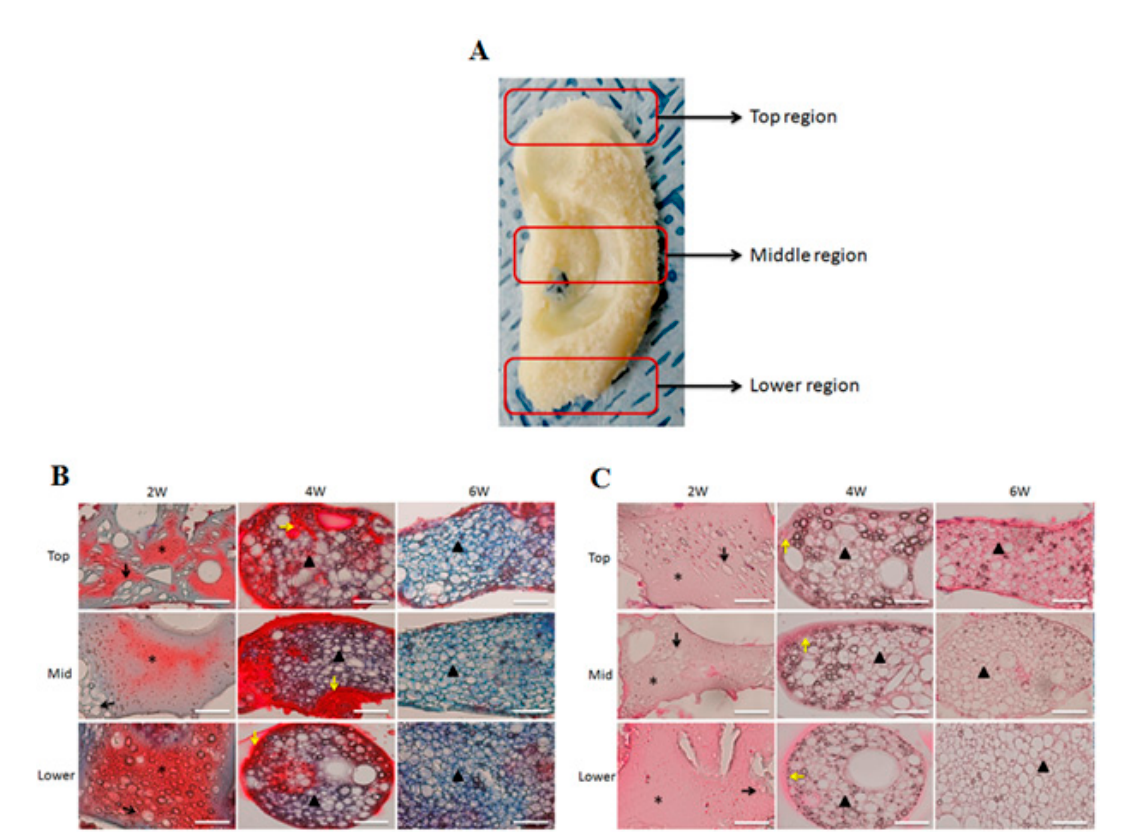
Figure 8. Histological examination of engineered ear-shaped cartilage: ( A ) Regions for the histological evaluation of engineered cartilage: the top, middle, and lower regions were evaluated for cartilage formation. ( B ) Masson’s Trichrome (MT) staining: ( C ) Hematoxylin and eosin (H&E) staining. At 2 weeks, there was a various-shaped immature lacunar structure (black arrows) within the cartilaginous matrix (stars). At 4 weeks, there was an increase in the number of lacunar structures surrounded by cytoplasmic constituents (yellow arrows) and immature cartilage (triangle). At 6 weeks, mature cartilage (triangle) with a typical chondrocyte lacunar network was visible. Scale bars = 200 μ m.